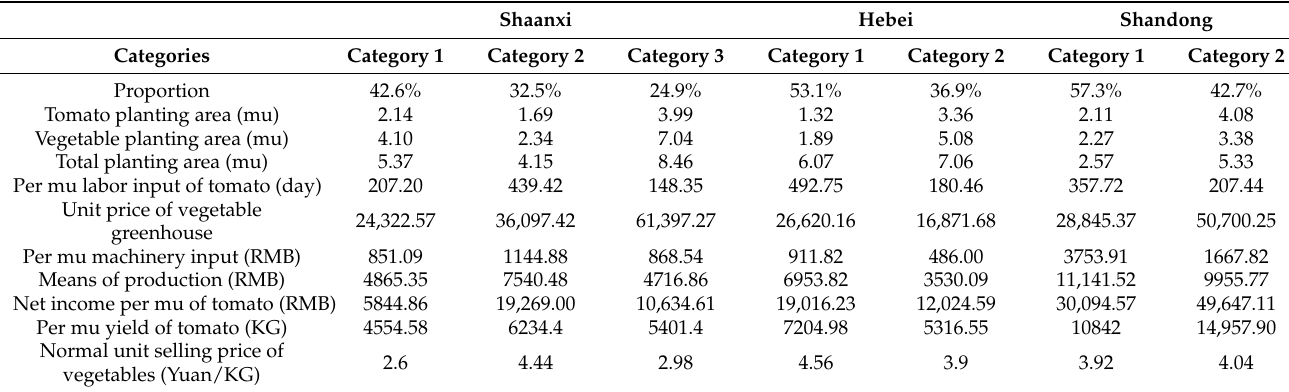
Table 3. Clustering analysis results of factor endowment structure and performance in Shaanxi, Hebei, and